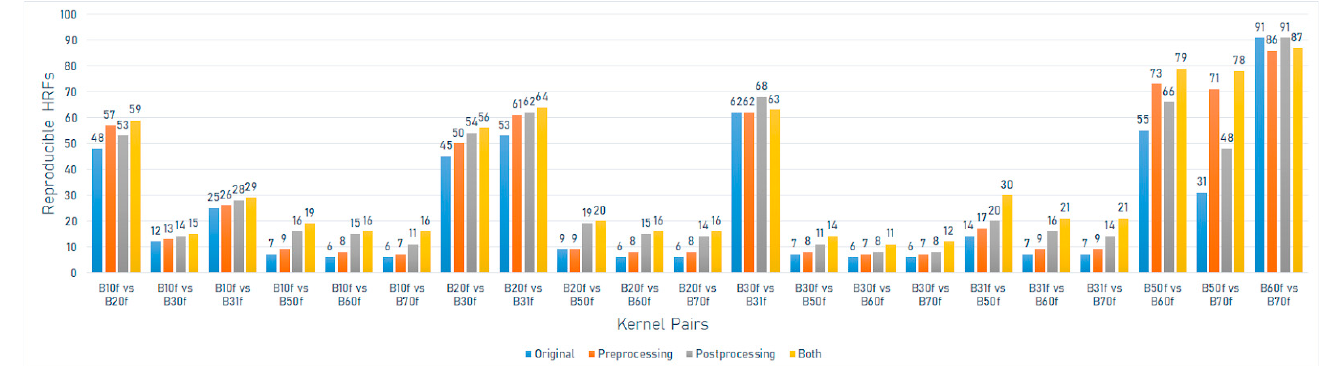
Figure 5. The number of reproducible HRFs across different kernels on the Sensation 64 scanner model.